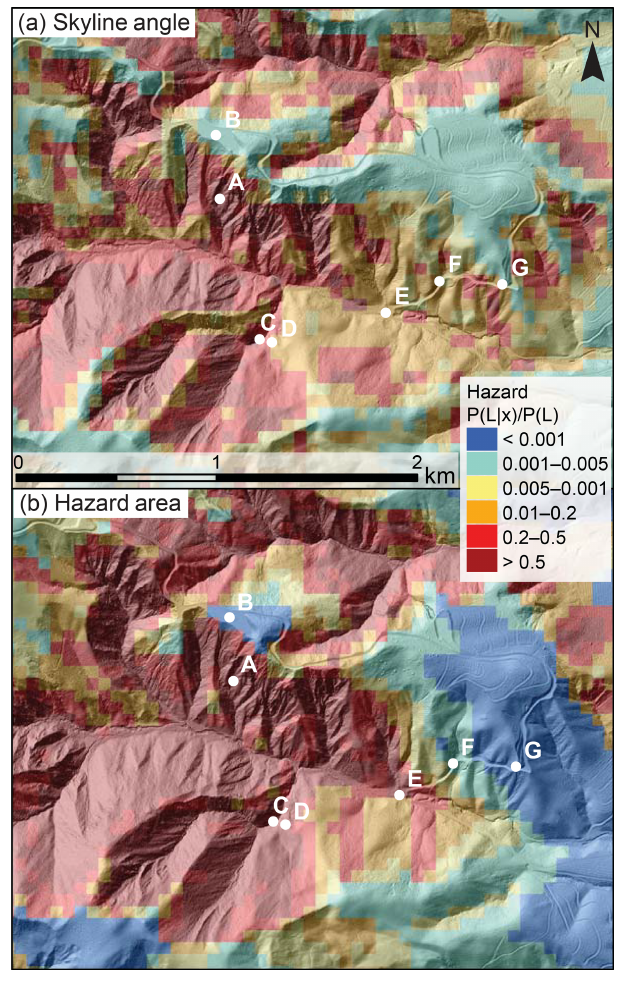
Figure 8. Example landslide hazard estimates derived from (a) sky- line angle and (b) hazard area for a small section of the Northridge study area. Colours reflect landslide hazard estimated from the two methods, expressed as a fraction of the study area av- erage hazard. Points labelled A–G in white are example lo- cations discussed in Sect. 7.4. Hazard estimates are overlain on a shaded-relief image derived from a 0.5m resolution lidar DEM for context (source: NCALM, 2015, http://opentopo.sdsc.edu/ datasetMetadata?otCollectionID=OT.072016.32611.1, last access: 29 March